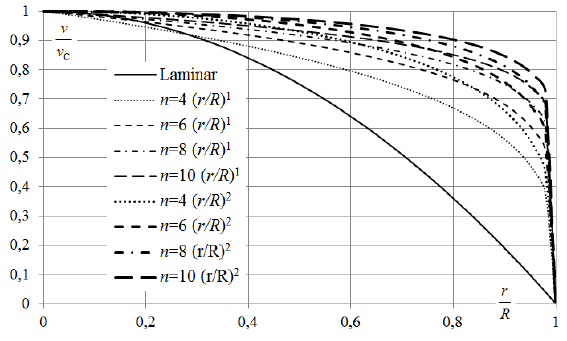
Fig. 3. Velocity distribution for fully developed flow